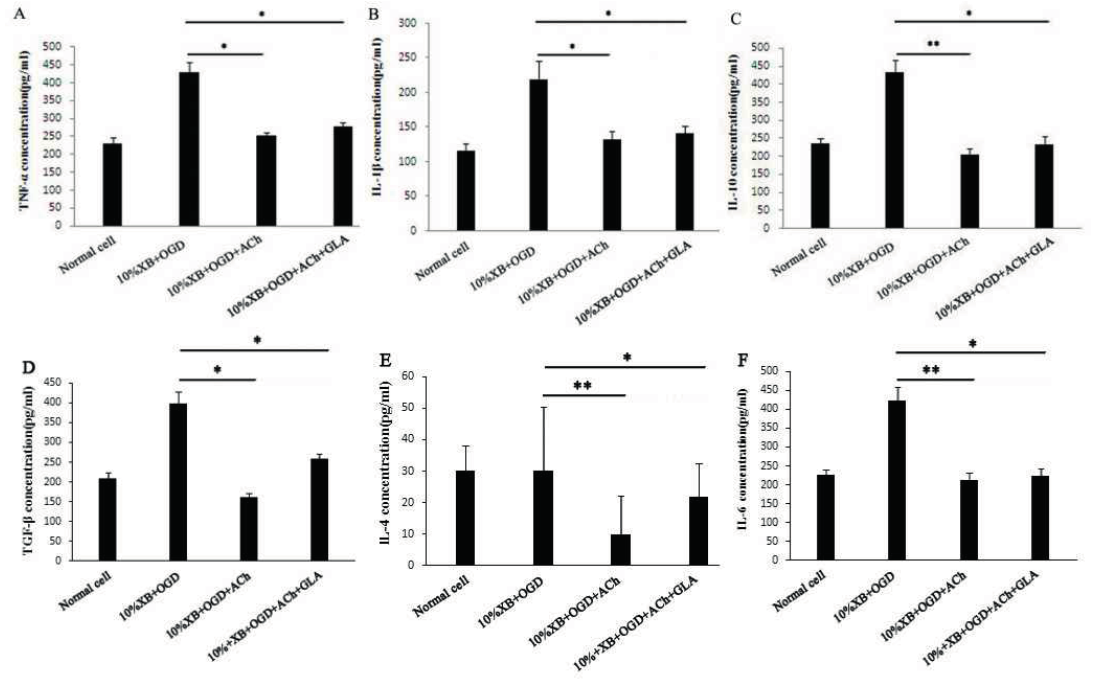
Figure1: Expression of inflammatory factors in renal macrophages of rats after being processed using different methods: (A) TNF- α , (B) IL-1 β , (C) IL-10, (D) TGF-β, (E) IL-4 and (F) IL-6. The results are presented as mean ± SD, * P < 0.05, ** P < 0.01.